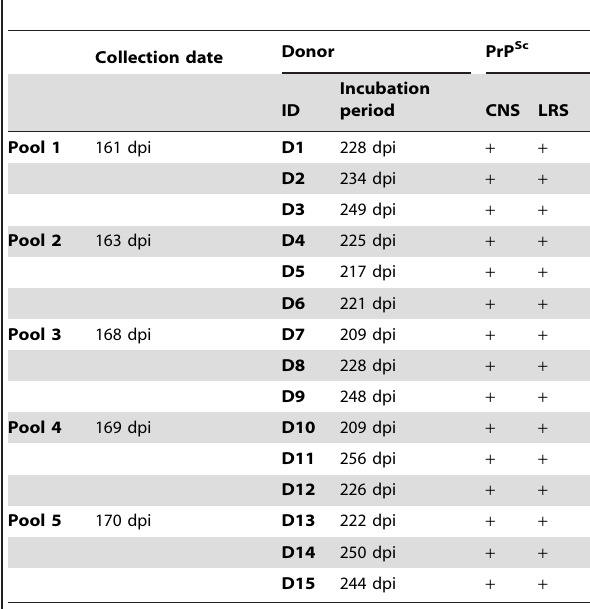
Table 1. Composition of the 5 sheep whole blood pools used for preparation of labile blood